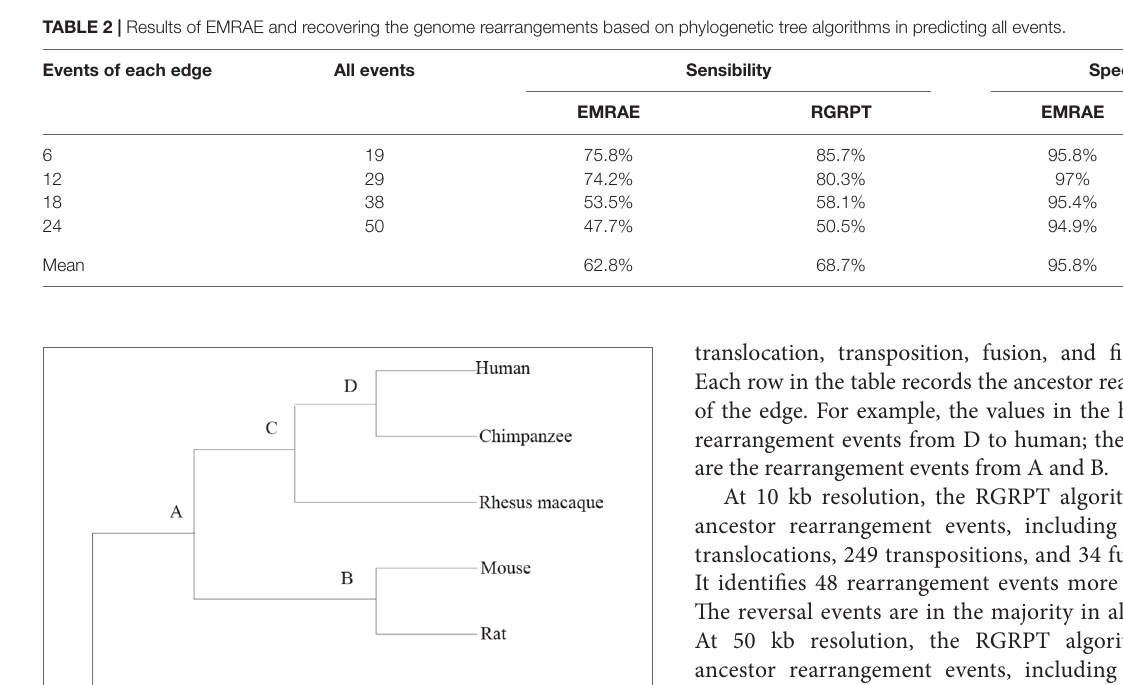
TABLE 3 | Genome rearrangement predictions of EMRAE and recovering the genome rearrangements based on phylogenetic tree at 10 kb resolution. Species Rev